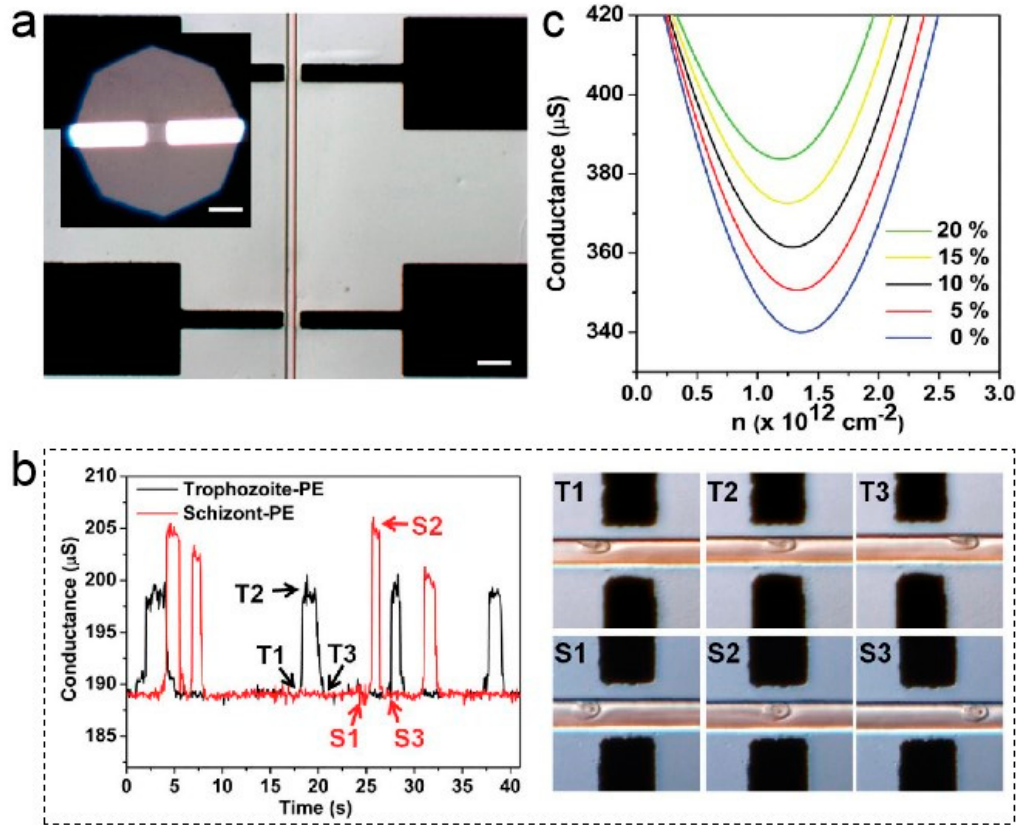
Figure 2. ( a ) Di ff erential interference contrast (DIC) image of independent graphene transistors with SU-8 / PDMS microfluidic channel. Inset shows the etched graphene strip between source and drain electrodes. ( b ) Conductance-time plots for (early to mid) trophozoite-PE and schizont-PE measured at Vg = 0.1 V and corresponding DIC images on the right. ( c ) Conductance vs carrier density, n, near CNP for protein-functionalized graphene in solution. Reproduced from [63] with permission of the American Chemical Society. Table 1. The di ff erence between a graphene-based electrical sensor and a graphene-based optical